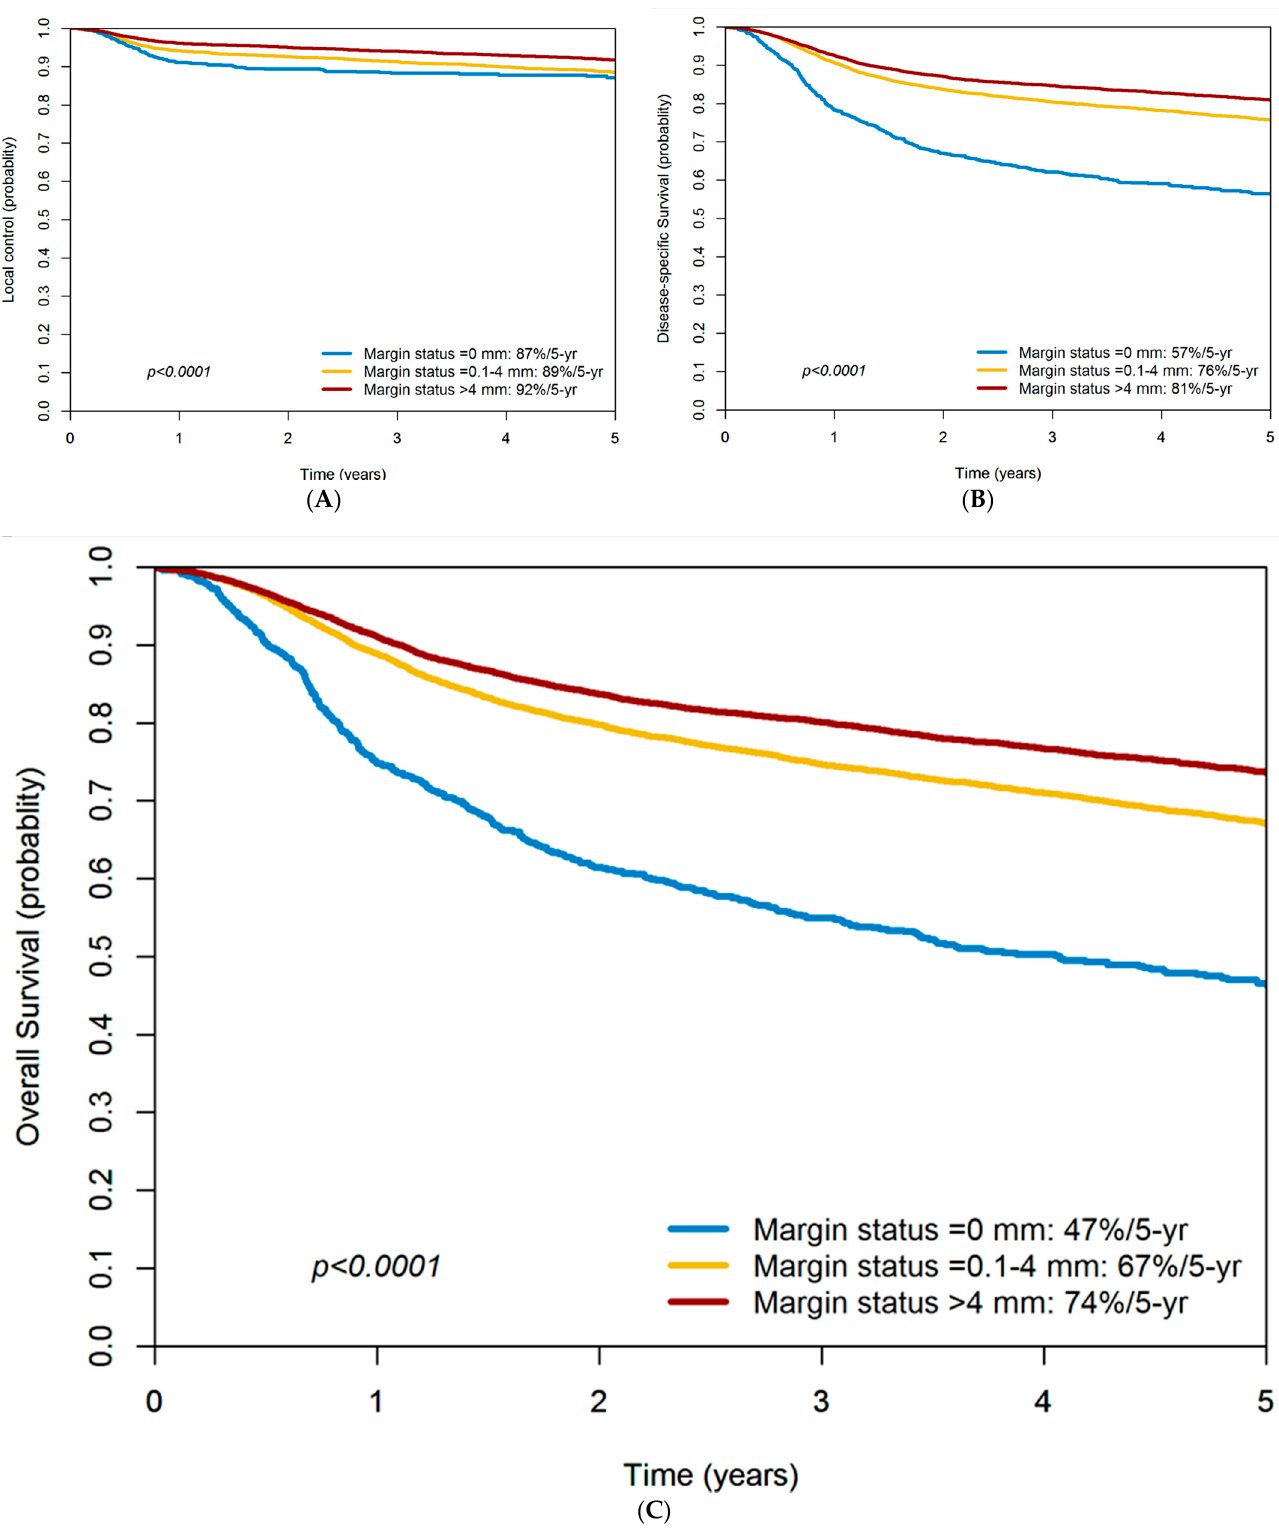
Figure 2. ( A ) Five-year local control rates of patients with oral cavity squamous cell carcinoma strat- ified according to different margin statuses (0, 0.1–4 and > 4 mm); ( B ) five-year disease-specific sur- vival rates of patients with oral cavity squamous cell carcinoma stratified according to different margin statuses (0, 0.1–4 and > 4 mm); ( C ) five-year overall survival rates of patients with oral cavity squamous cell carcinoma stratified according to different margin statuses (0, 0.1–4 and > 4